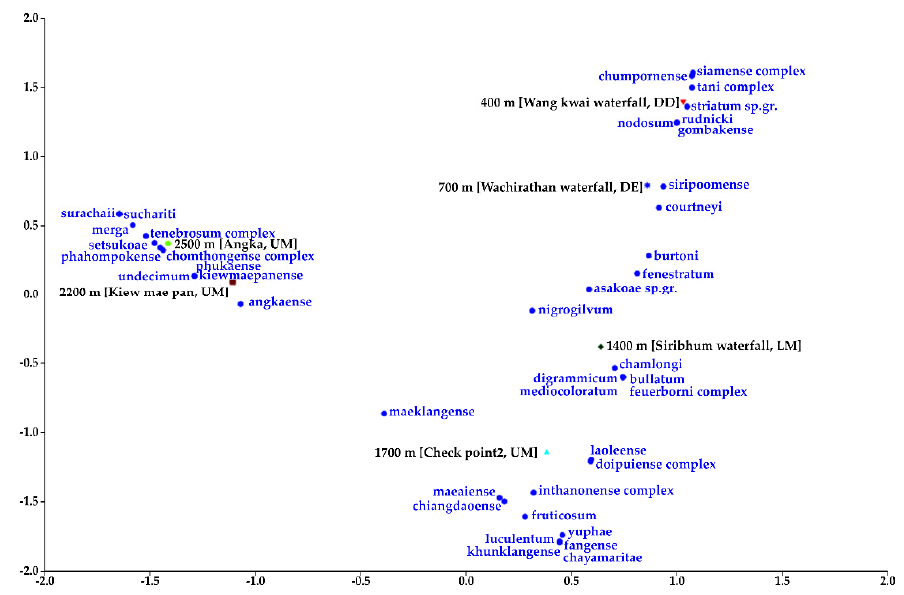
Figure 5. Ordinate diagram of the CA of the 44 black fly species distributed in six collection sites, which correlated to the elevational gradients and forest types of Doi Inthanon National Park. DD: deciduous dipterocarp forest; DE: dry evergreen forest; LM: lower montane rain forest; UM: upper montane rain forest.